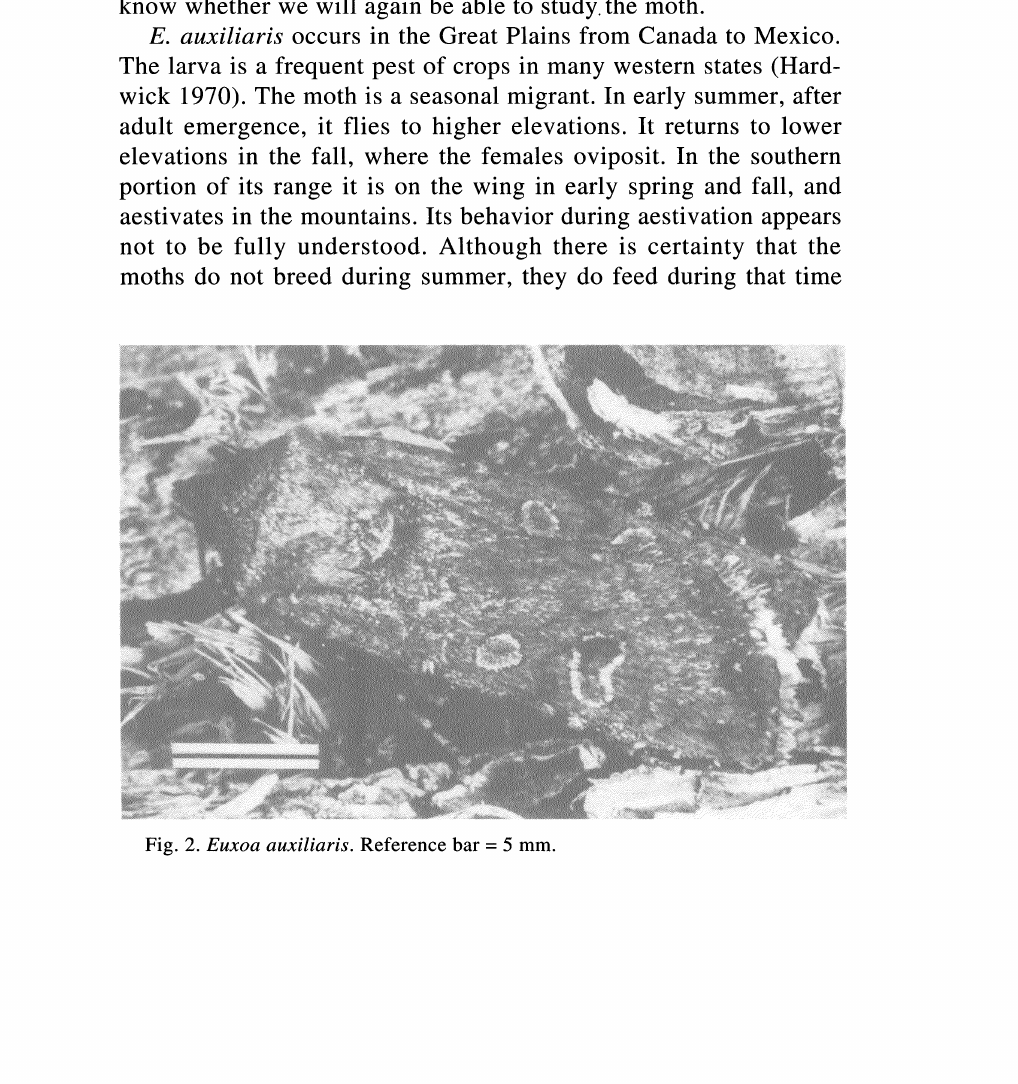
Fig. 2. Euxoa auxiliaris. Reference bar 5